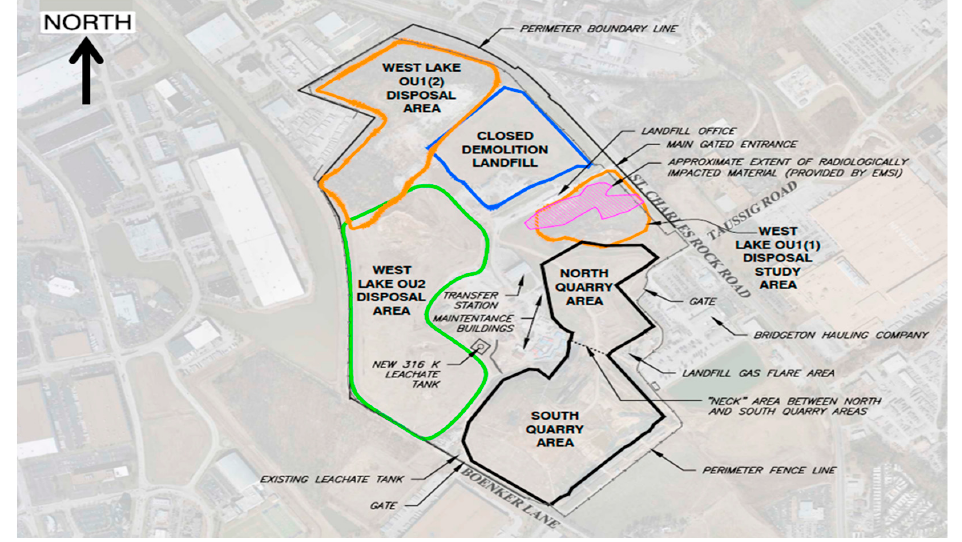
Figure 1. Outlines of Bridgeton landfill areas [20].